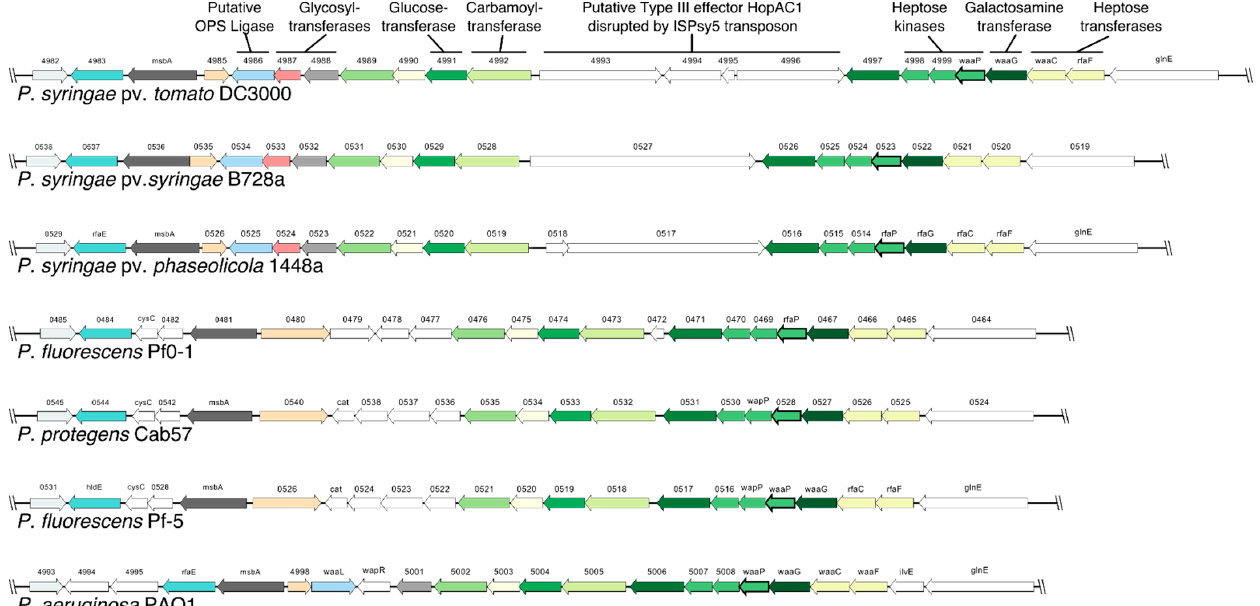
Figure 2. Synteny analysis of the core-OS cluster in Pseudomonas strains. Gene structure of the Pst DC3000 core-OS cluster and hits from synteny analysis of corresponding genes in selected Pseudomonas strains. Matching colors indicate corresponding gene hits.